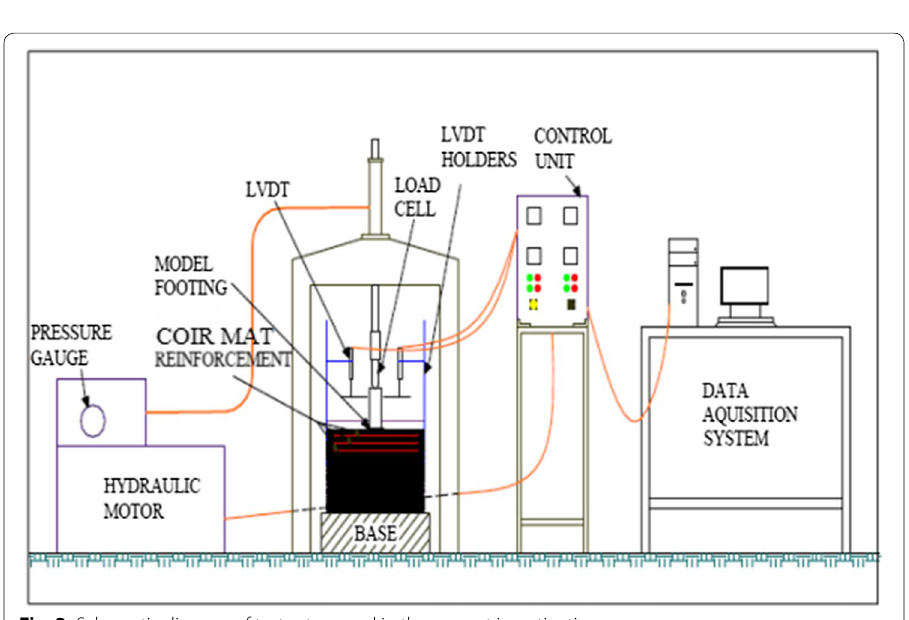
Fig. 3 Schematic diagram of test setup used in the present